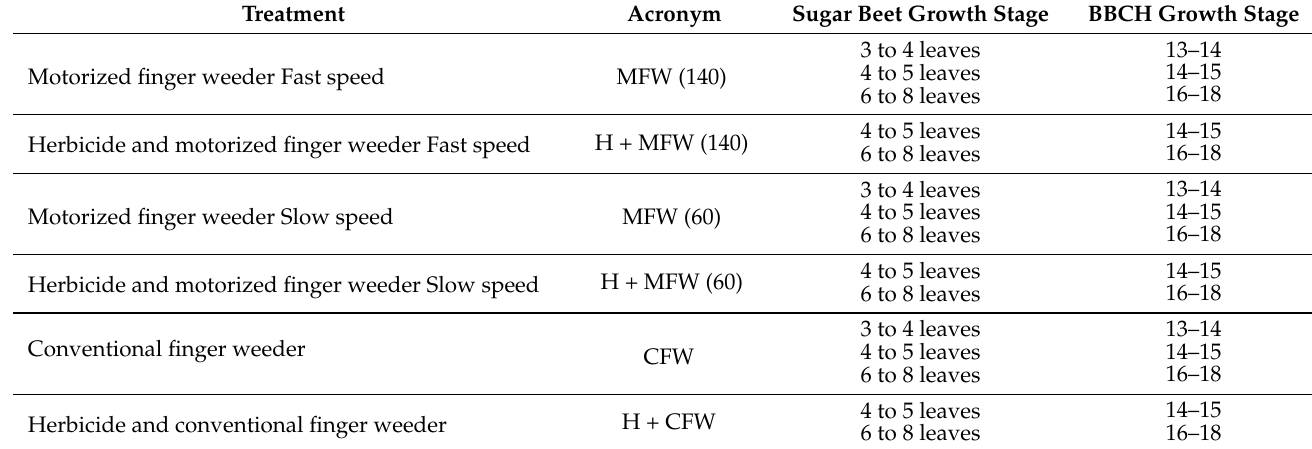
Table 4. Time of application of the mechanical treatments at Ihinger Hof according to the number of developed leaves and the BBCH stage